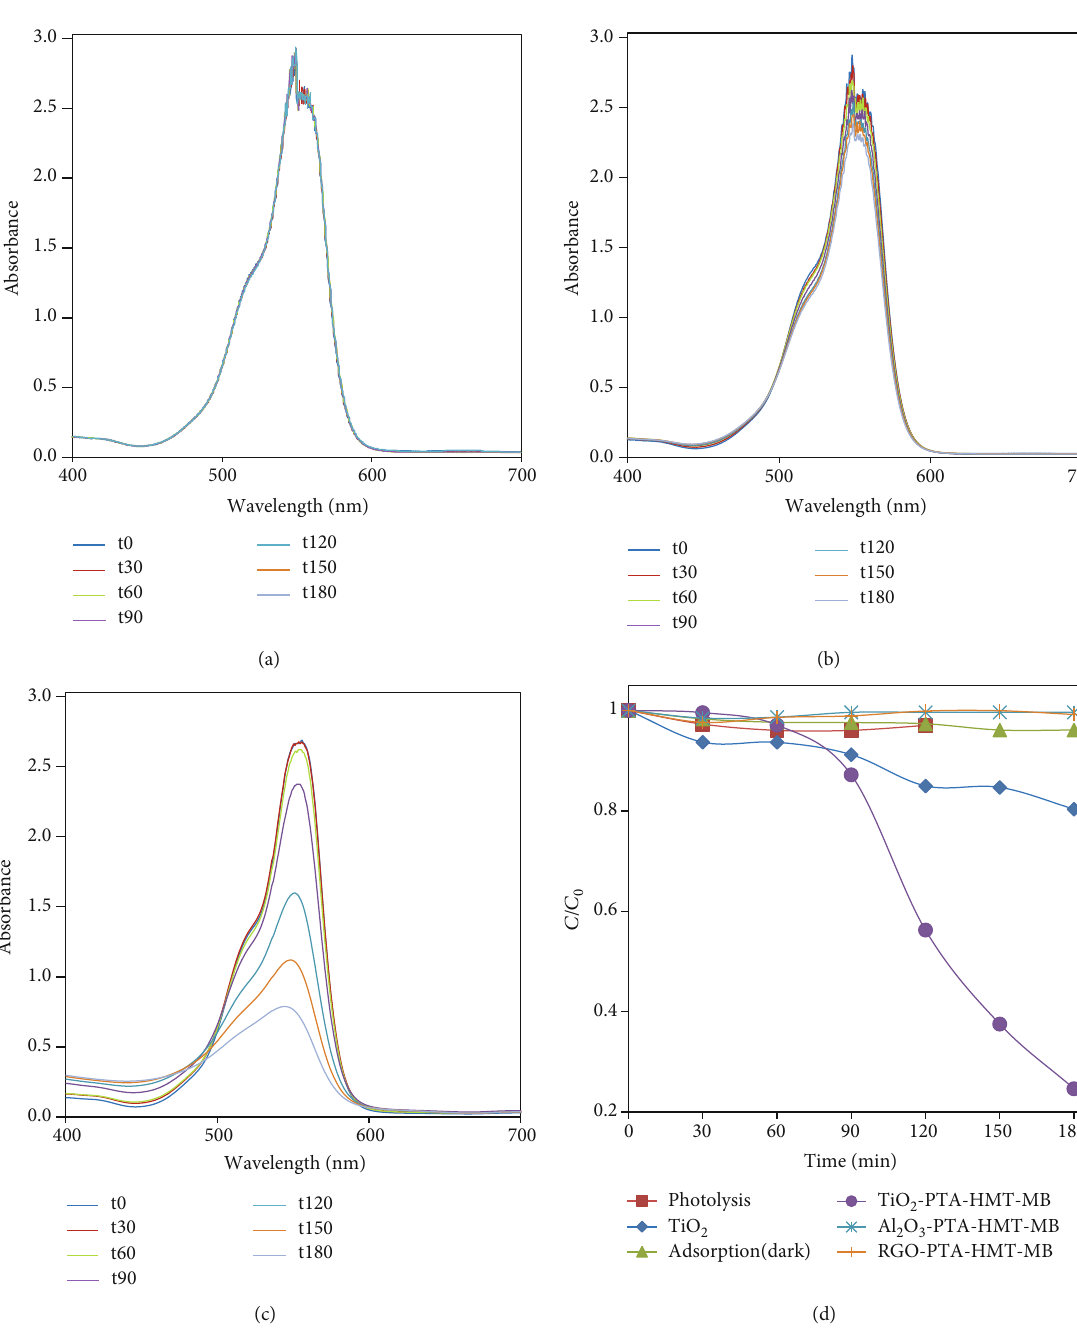
(0.15g/L) (b), in the presence of TiO 2